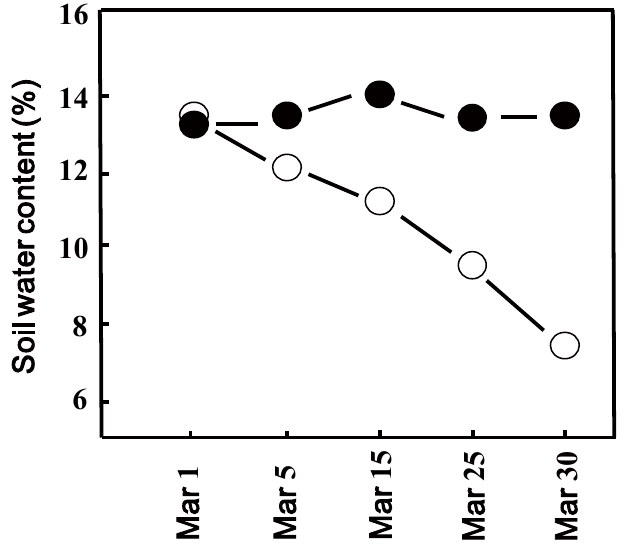
Figure 1. Soil volumetric water content (%) of watered (closed circles) and drought (open circles) exposed experimental block. Values represent the mean of four individual soil samples per plot. Deviation of individual values was less than